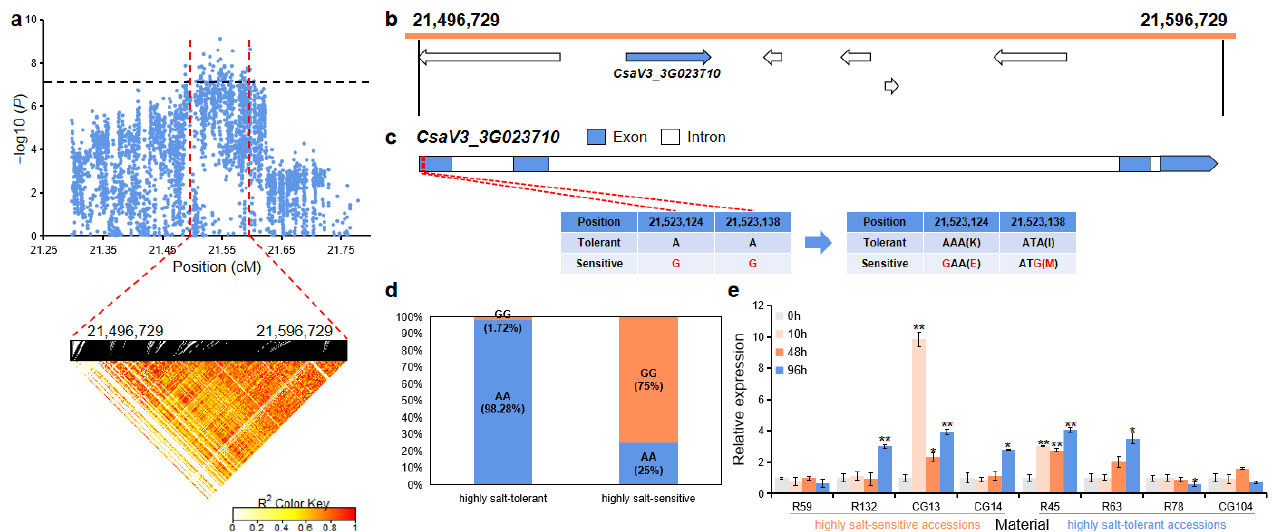
Figure 6. Identification of the candidate gene that was related to salt tolerance for the locus gST3.1 . ( a ) Manhattan plot and LD heatmap of gST3.1 . The black dashed line represents the significance threshold and the red dashed lines represent the candidate region (100 kb). ( b ) A total of six functional annotated genes were predicted in the gST3.1 candidate region. The blue arrow indicates that the functional annotation of the gene which is related to salt tolerance. ( c ) Gene structure of CsaV3_3G023710 . Blue rectangles and white rectangles indicate exons and introns, respectively. ( d ) Orange and blue blocks represent the proportion of GG and AA haplotype in the highly salt-tolerant or highly salt-sensitive accessions, respectively. ( e ) qRT-PCR was used to detect the expression changes of CsaV3_3G023710 in the highly salt-sensitive accessions (R59, R132, CG13, and CG14) and highly salt-tolerant accessions (R45, R63, R78, and CG104) after salt treatment (0 h, 10 h, 48 h,